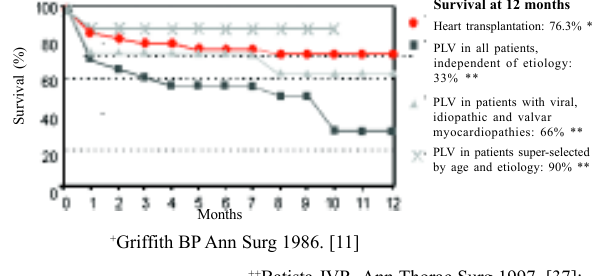
Fig. 3 – Actuarial survival rate. Comparative analysis of the estimate of survival for heart transplant patients and patients submitted to partial left